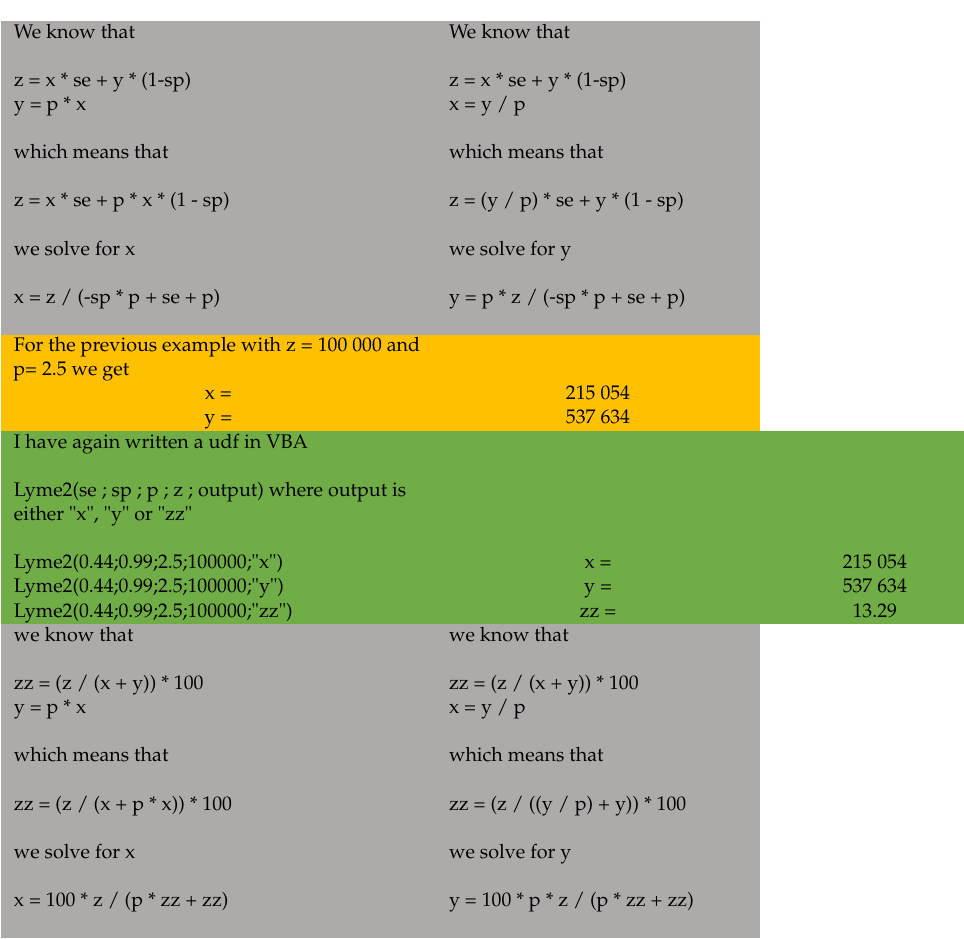
Table 3. Algebraic manipulation of previous